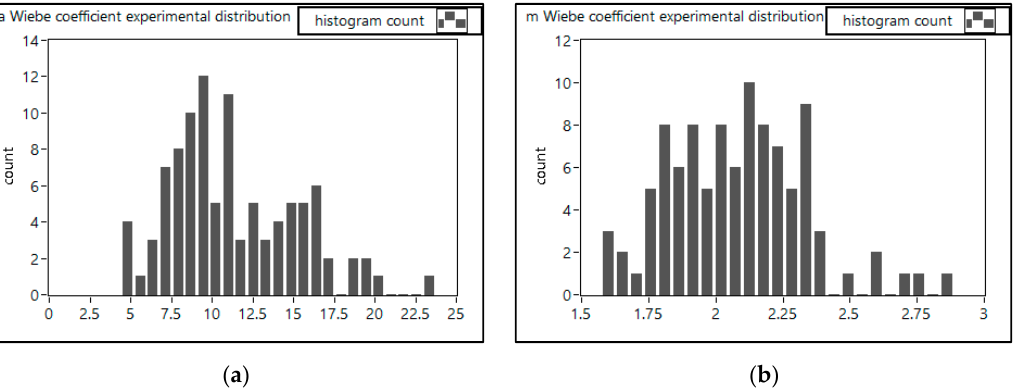
Figure 12. Histograms of Wiebe coefficients experimental distribution; MAP = 1 bar, n = 3500 rpm, fuel NG. ( a ) a coefficient (mean value = 11.2, SD = 3.93); ( b ) m coefficient (mean value = 2.08, SD = 0.254).